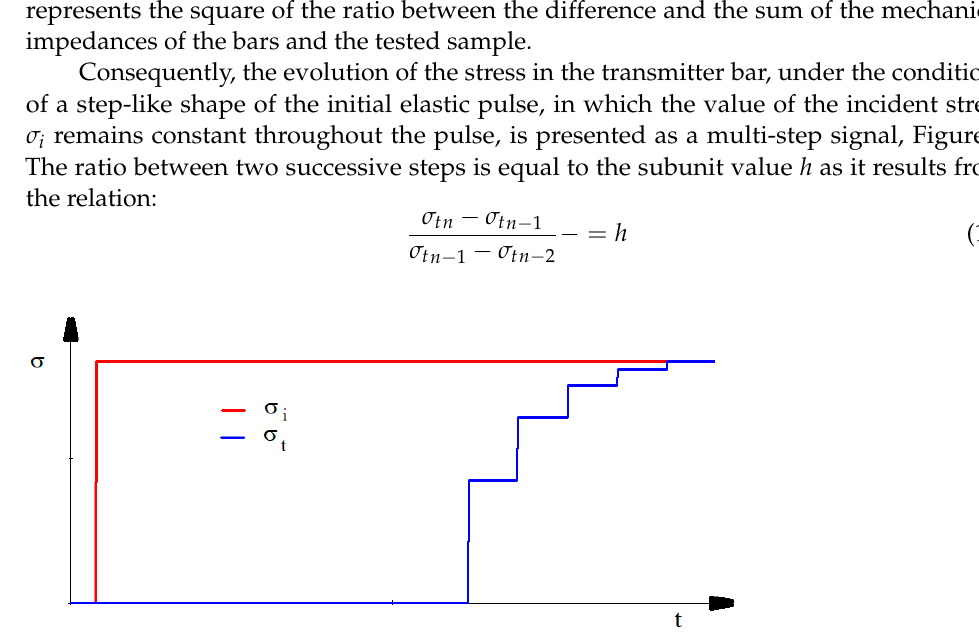
Figure 1. Transformation of a single-step elastic pulse into a multi-step elastic pulse when passing through a sample with a different mechanical impedance than the bars.